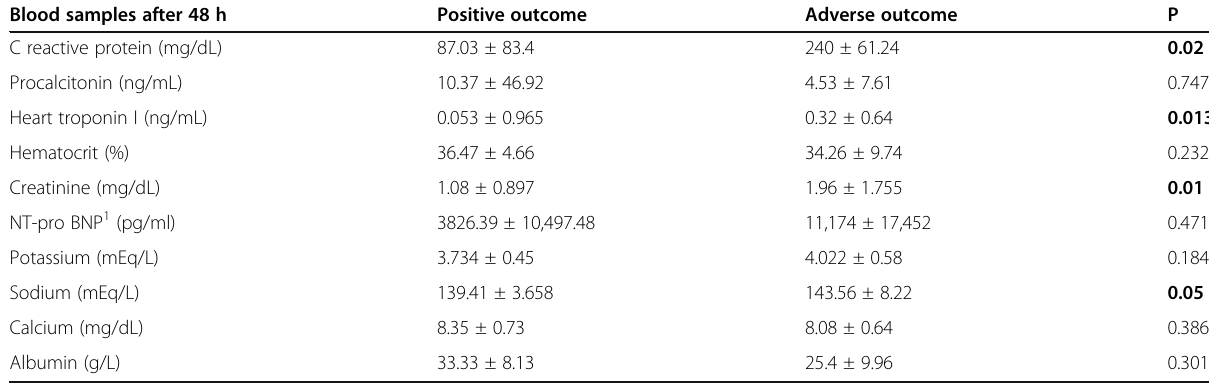
Table 3 Blood samples after 48 h Blood samples after 48 h Positive outcome Adverse outcome P C reactive protein